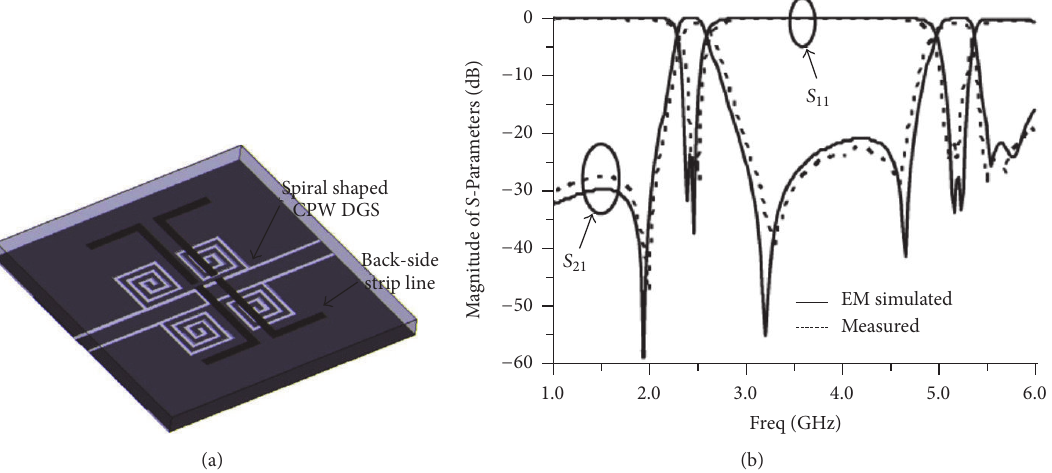
Figure 20: (a) Layout of the proposed quasi-elliptic function dual-band BPF stacking spiral shaped CPW DGS and back-side coupled strip lines; (b) 𝑆 -parameter response